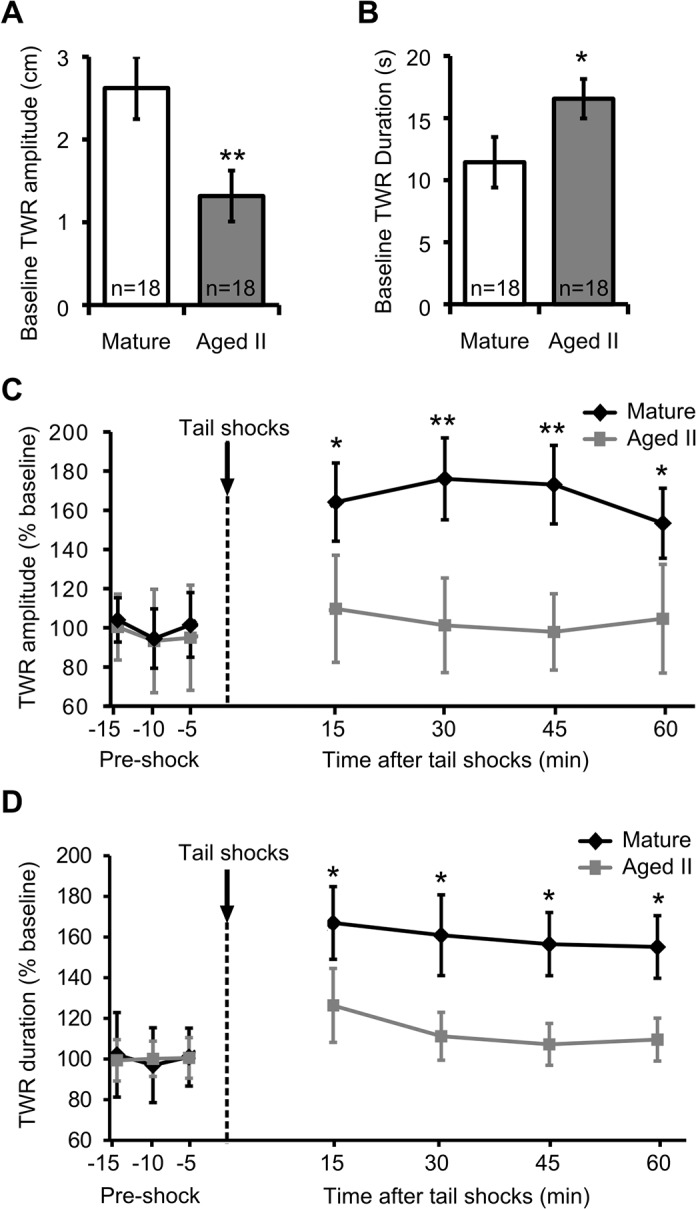
Sensitization in TWR of intact animals declined during aging.A) TWR amplitude in baseline pretests decreased, while (B) TWR duration increased significantly during aging. * and ** denote significant difference compared to mature at p≤0.05 and p≤0.01, respectively, via 2-sample t-tests. C) TWR amplitude and (D) TWR duration increased significantly in mature animals following five sensitizing shocks (1.5 s each, 100 mA, AC, 1 s interstimulus interval) delivered to the anterior tail, while in the same animals at stage aged II no shock-induced change in amplitude or duration was observed. * and ** denote increase compared to baseline at p≤0.05 and p≤0.01, respectively, via Tukey’s posthoc tests following repeated measures ANOVA (n = 18).